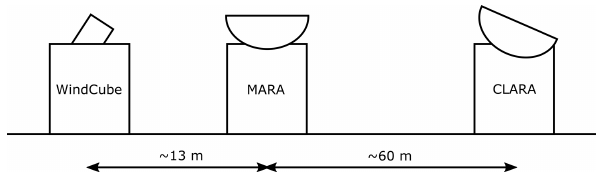
Figure 1. Conceptual illustration (not to scale) of the horizon- tal separation between the lidar and radars operated during CM-